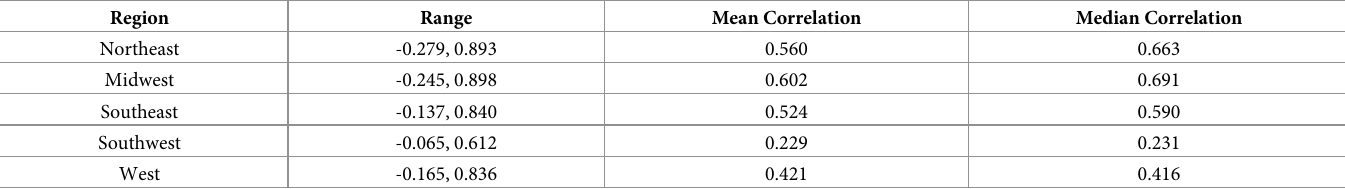
Table 3. Summary values of bivariate correlation of full-term list search terms to regional Lyme disease rates of model training data. Region